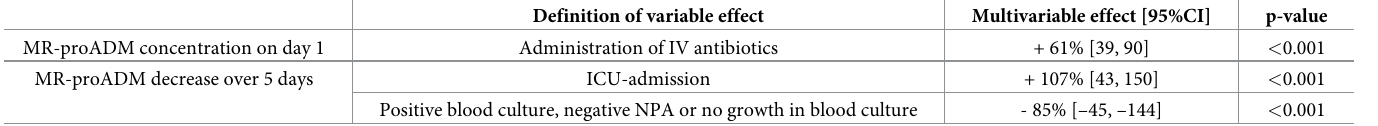
Table 2. MR-proADM: Variables effect on MR-proADM kinetics in multivariable analysis as compared to the typical